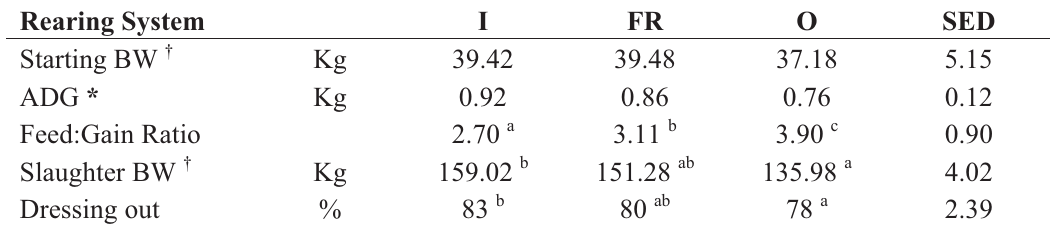
Table 2. Effect of rearing system on productive performance of